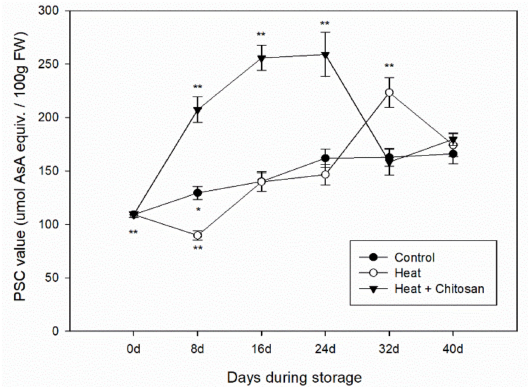
Figure 5. Total antioxidant activity (PSC value) of ‘Sanhua’ plum fruit during storage. Error bars represent for standard errors. Control: fruits without treatment; Heat: fruits with hot air treatment at 37 ◦ C for 6 h; Heat and chitosan: fruits treatment with hot air (37 ◦ C, 6 h) and 1% chitosan. * and ** mean significant di ff erences at p < 0.05 and p < 0.01 level,